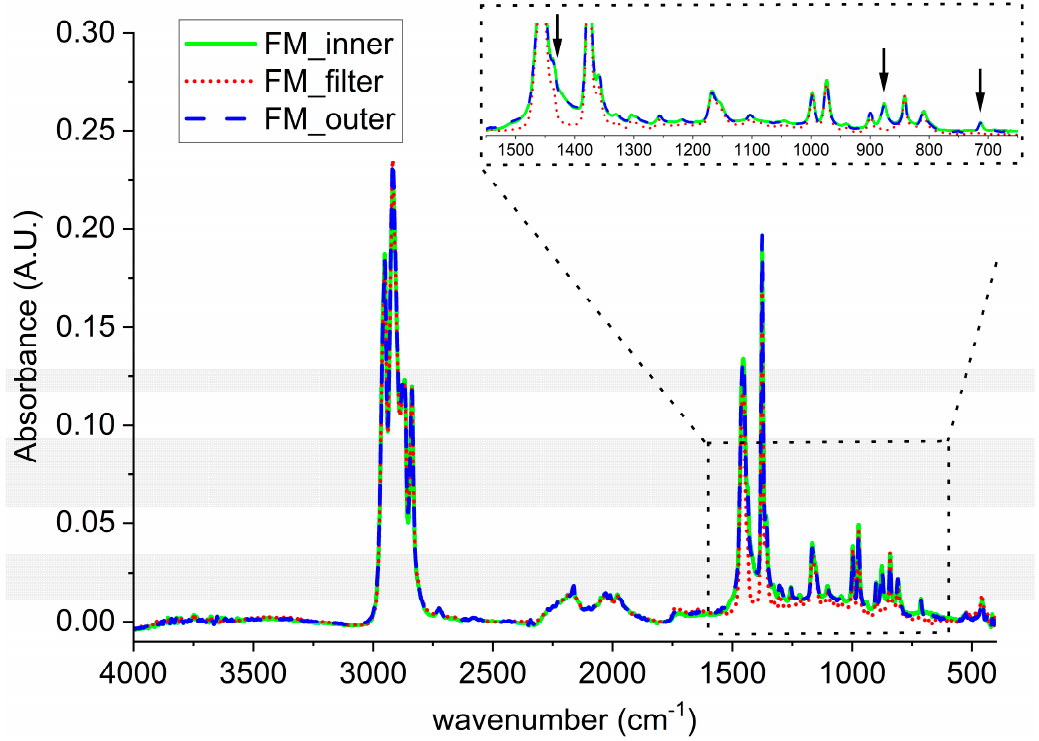
Figure 3. ATR analyses on: (red) FM_filter; (blue) FM_outer; (green) FM_inner part of the disposable mask.